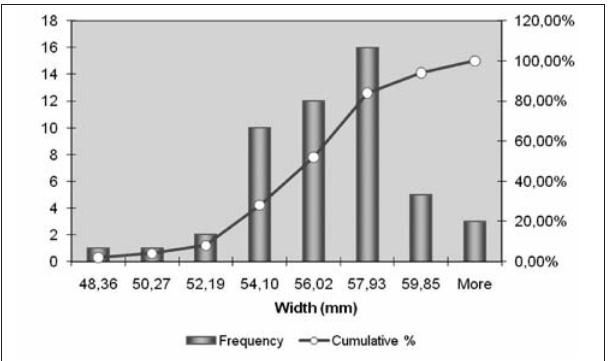
Fig. 33: Distribution of width values of category AAA of Bergeron